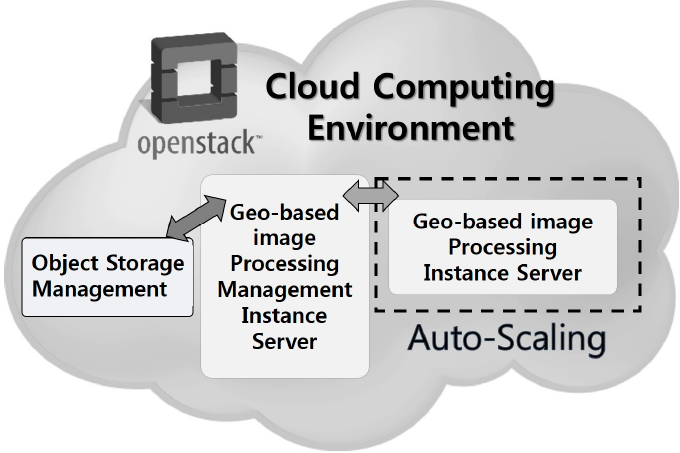
Figure 2. Auto-scaling components in satellite image processing system in a cloud computing